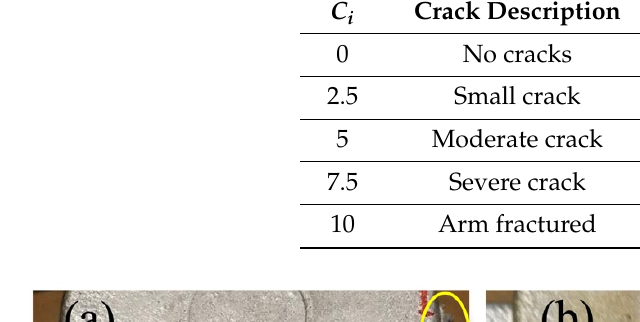
Table 3. Assigned cracking index, C i , for each casting arm.